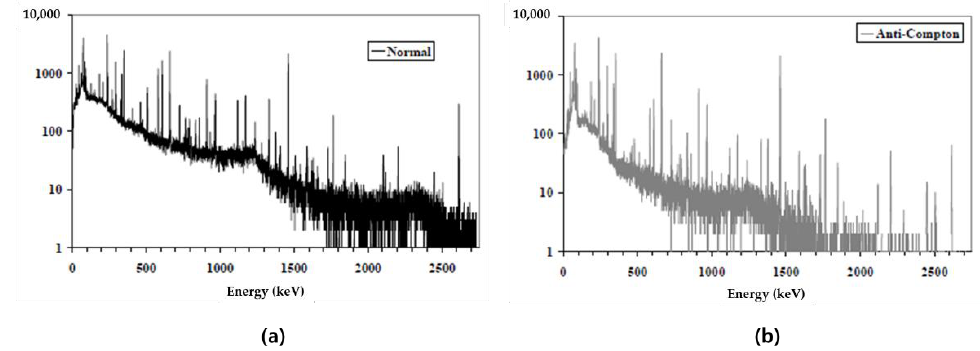
Figure 11. Compton suppression results using U, Th source ( a ) Spectrum with Compton suppression unapplied ( a ) and applied spectrum ( b ) [38].